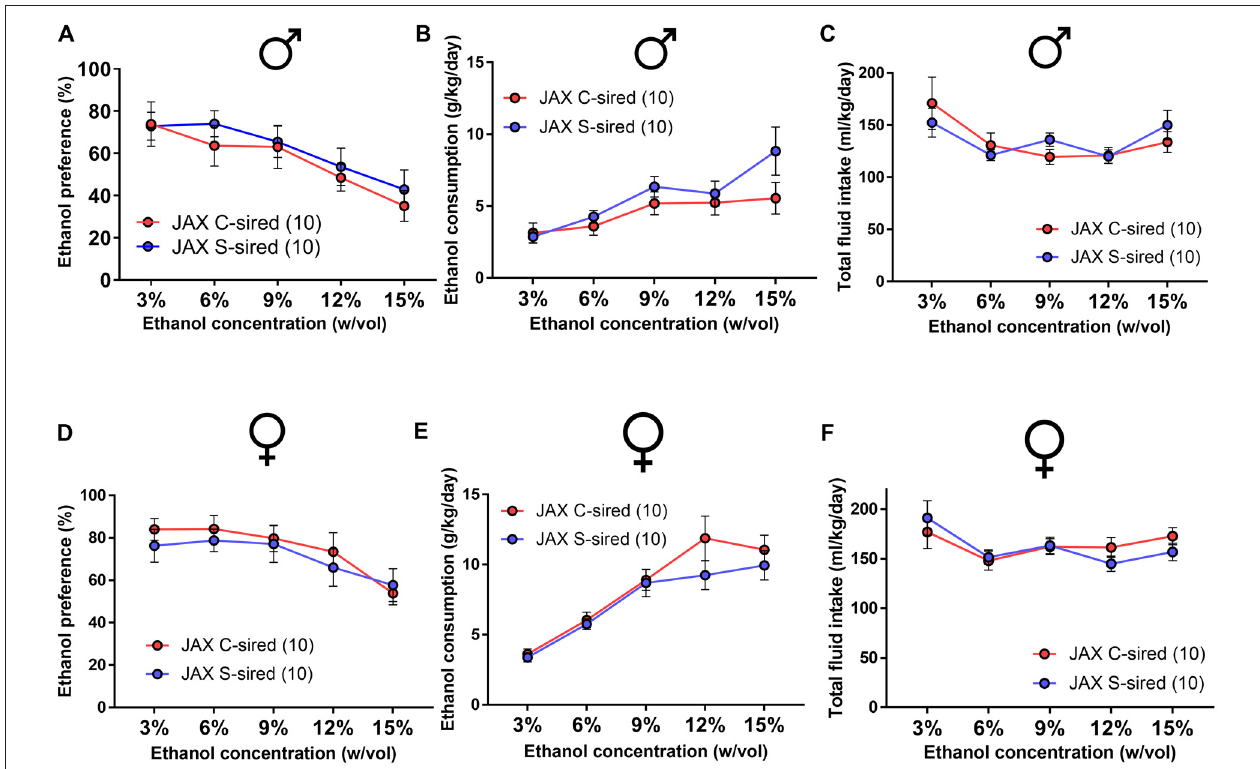
FIGURE 6 | No effect of JAX-sire paternal stress on offspring ethanol drinking. No effect of paternal stress on ethanol preference, ethanol consumption and total fluid intake of (A–C) males ( N = 10/group) or (D–F) females ( N = 10/group) in the two-bottle, free choice drinking assay.